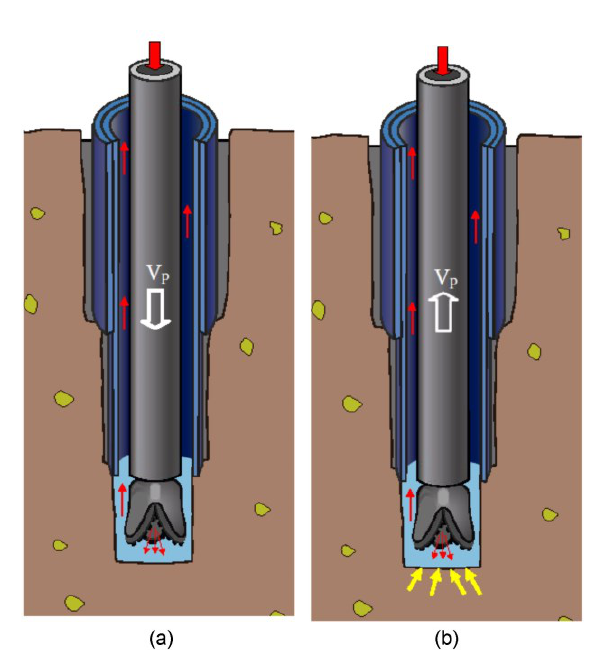
Fig. 1: Geopressures: (a) Surge and (b)